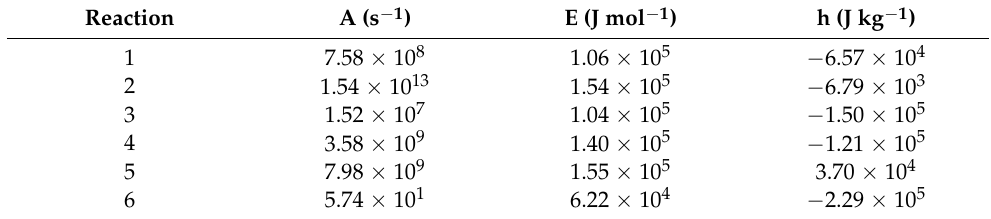
Table 1. Reaction kinetic parameters of the FR_PU_aerogel thermal degradation. Here, a negative value in the heat of reaction (h) represents an endothermic process.